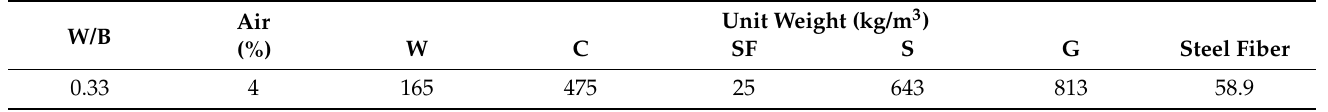
Table 2. Mix Design of Steel Fiber-Reinforced Concrete